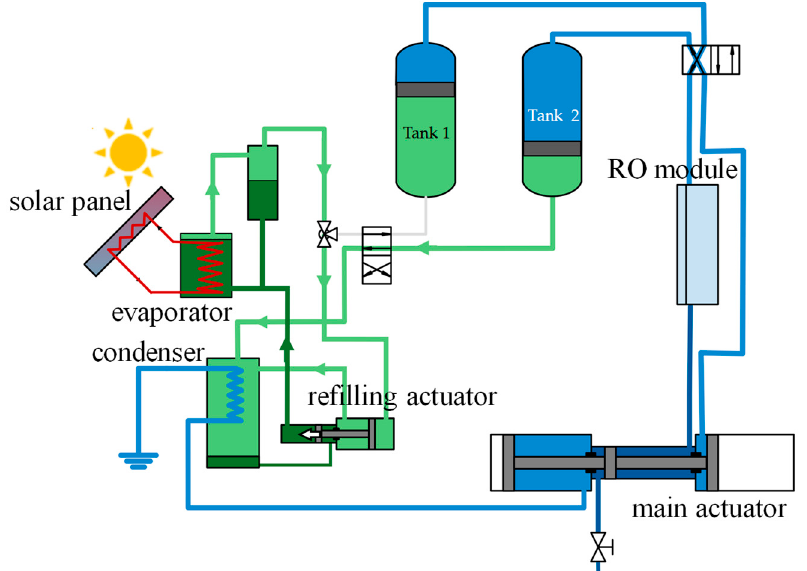
Figure 3. Flow diagram of the thermo-hydraulic desalination process during the liquid refilling phase of the evaporator by the second cylinder, which is put in motion by the high-pressure vapor supplied by the evaporator during the beta phases of the cycle.